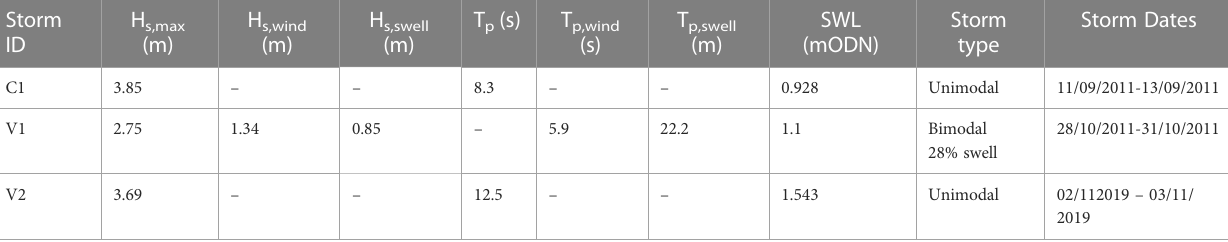
TABLE 1 Storm conditions extracted from the Milford wave buoy for XBeach-G calibration (C1) and validation (V1 & V2). Storm ID